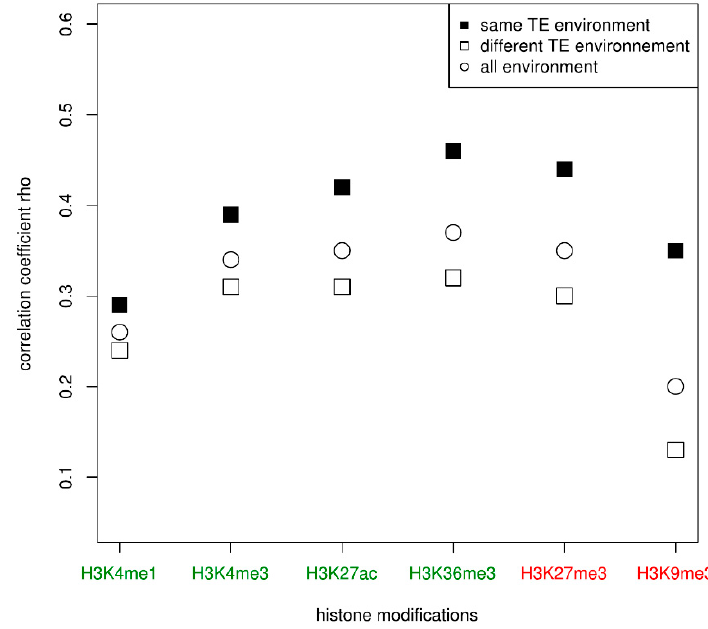
Figure 3. Correlations of the histone enrichment between paired genes according to the similarity of their TE neighborhood in the four cell types. Activating and repressive histone modifications are represented, respectively, in green and red.